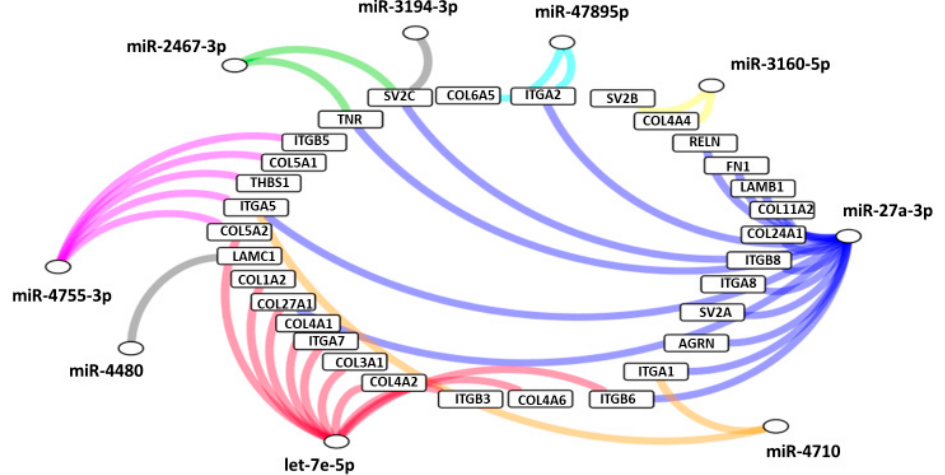
Figure 8. Predicted genes targeted by miRNAs in extracellular matrix receptor interaction pathway, in the vitreous of VRL patients compared with uveitis. Selected inflammatory genes targeted by each group of miRNAs are depicted in a network diagram. Differentially expressed miRNAs that do not target any of the selected genes are not shown. AGRN: agrin, COL: collagen, FN: fibronectin, ITGA; integrin alpha, ITGB: integrin beta, LAMB: laminin beta, LAMC: laminin gamma, RELN: reelin, SV: synaptic vesicle glycoprotein, THBS: thrombospondin, TNR: tenascin R.